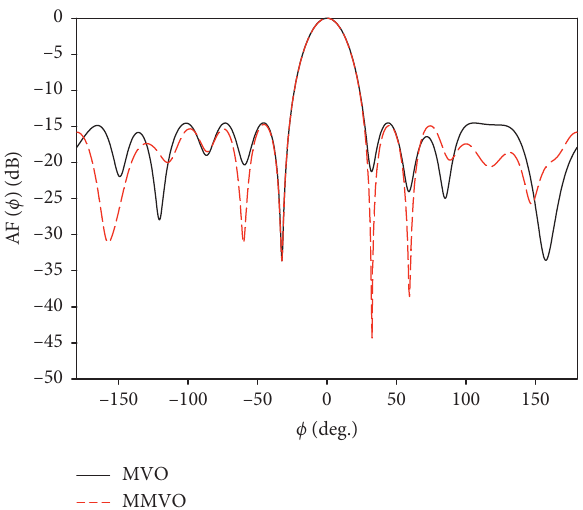
Figure 5: Radiation pattern of the optimized 10-element CAA.